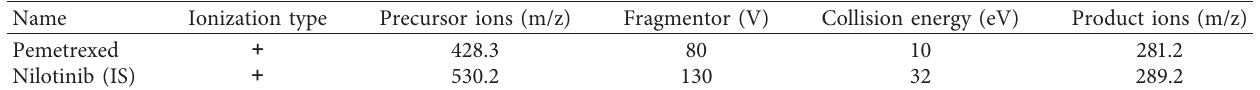
Figure 1: Product ions chromatograms and fragment structures of pemetrexed and nilotinib (IS). (a) Pemetrexed. (b) Nilotinib (IS). Table 1: Main mass spectral parameters of pemetrexed and